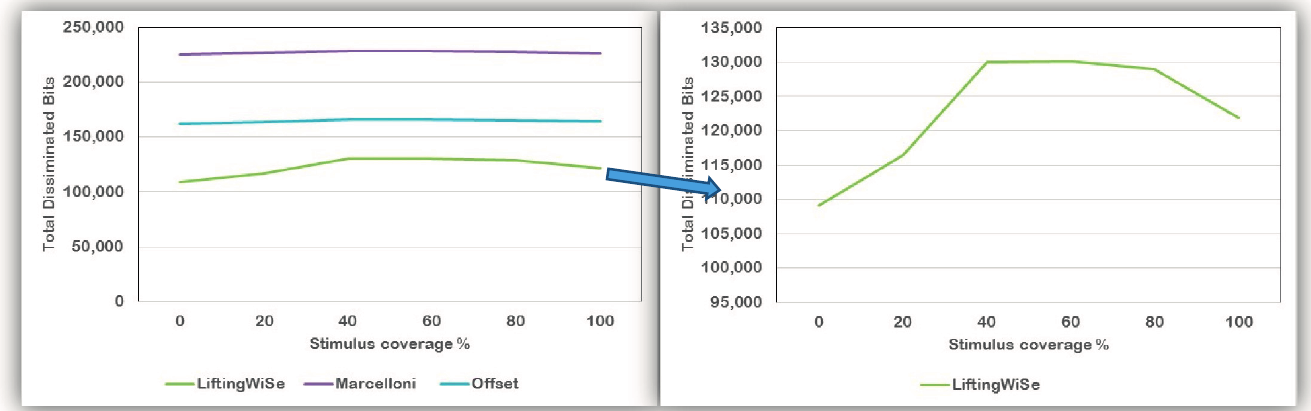
Figure 13. The stimulus coverage effect on the number of disseminated